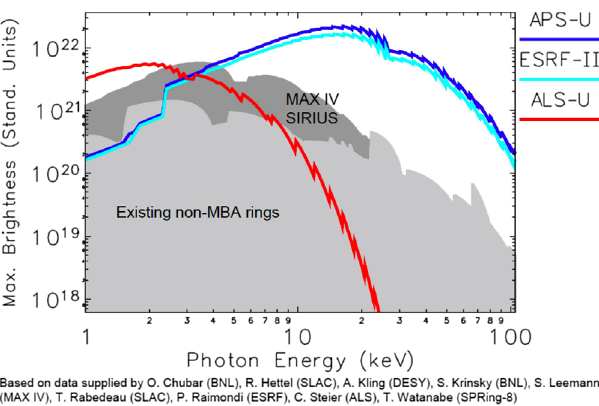
; ε Þ ¼ ð 320 pm ; 8 pm Þ x y ¼ 4 . 5% [28] (From MAX IV p